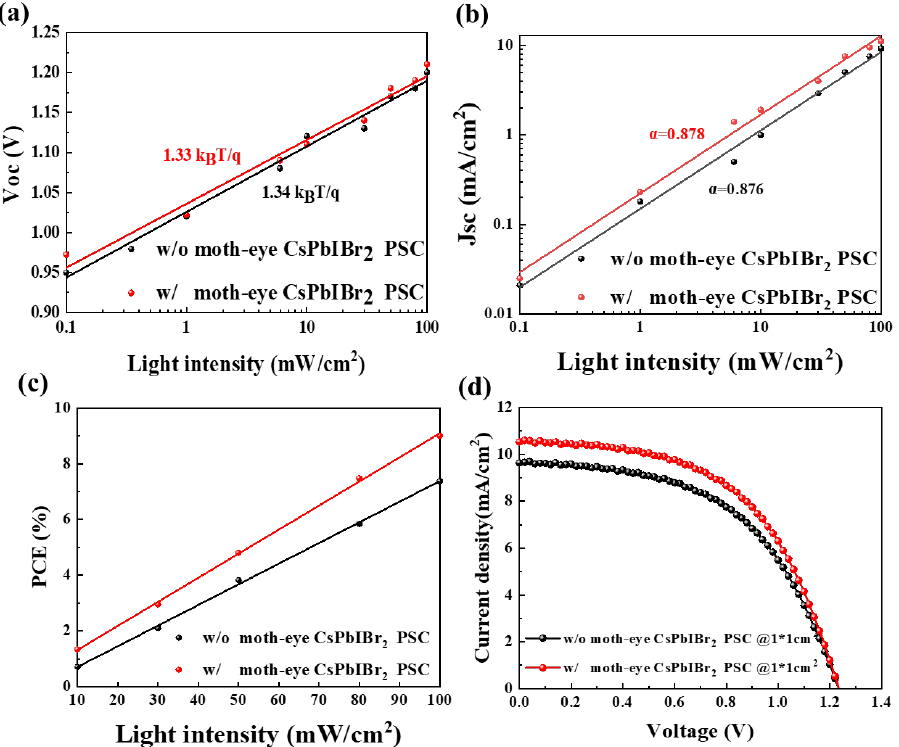
Figure 6. ( a – c ) Characteristic curve at different light intensity and ( d ) J – V curve of CsPbIBr 2 PSC with and without moth-eye